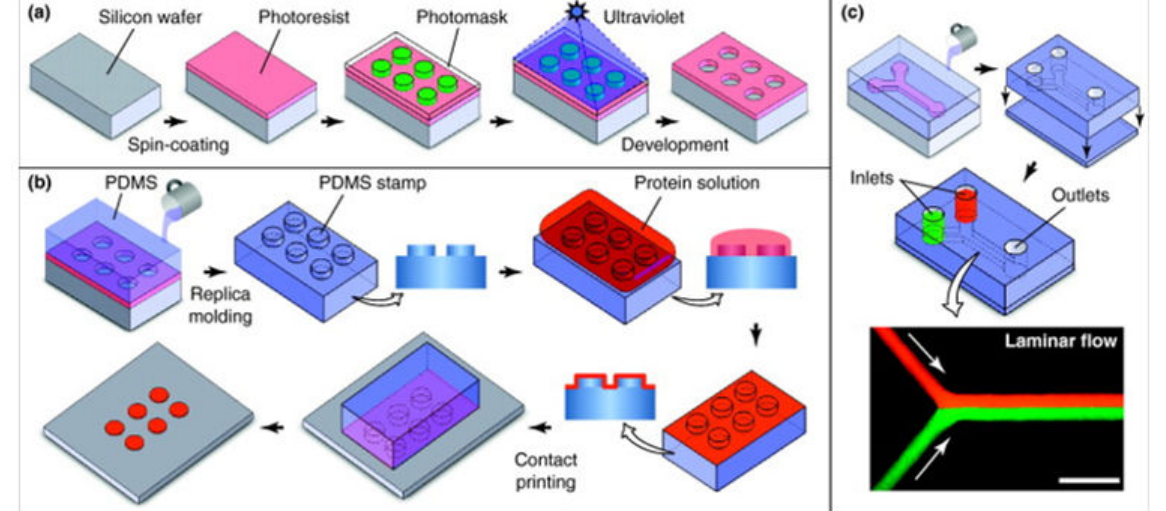
Figure 7. Microengineering technologies used to construct 3D culture systems and organs-on-chips. ( a ) Photolithography, ( b ) soft lithography, ( c ) microfluidic devices. Reprinted with permission from [207]. Copyright (2011)